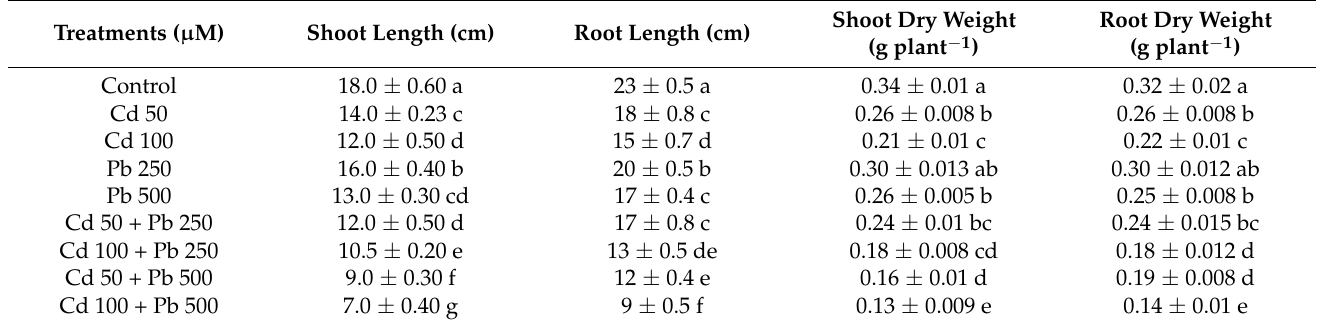
Table 1. Shoot and root growth of quinoa plants exposed to various concentrations of cadmium and lead under hydroponic